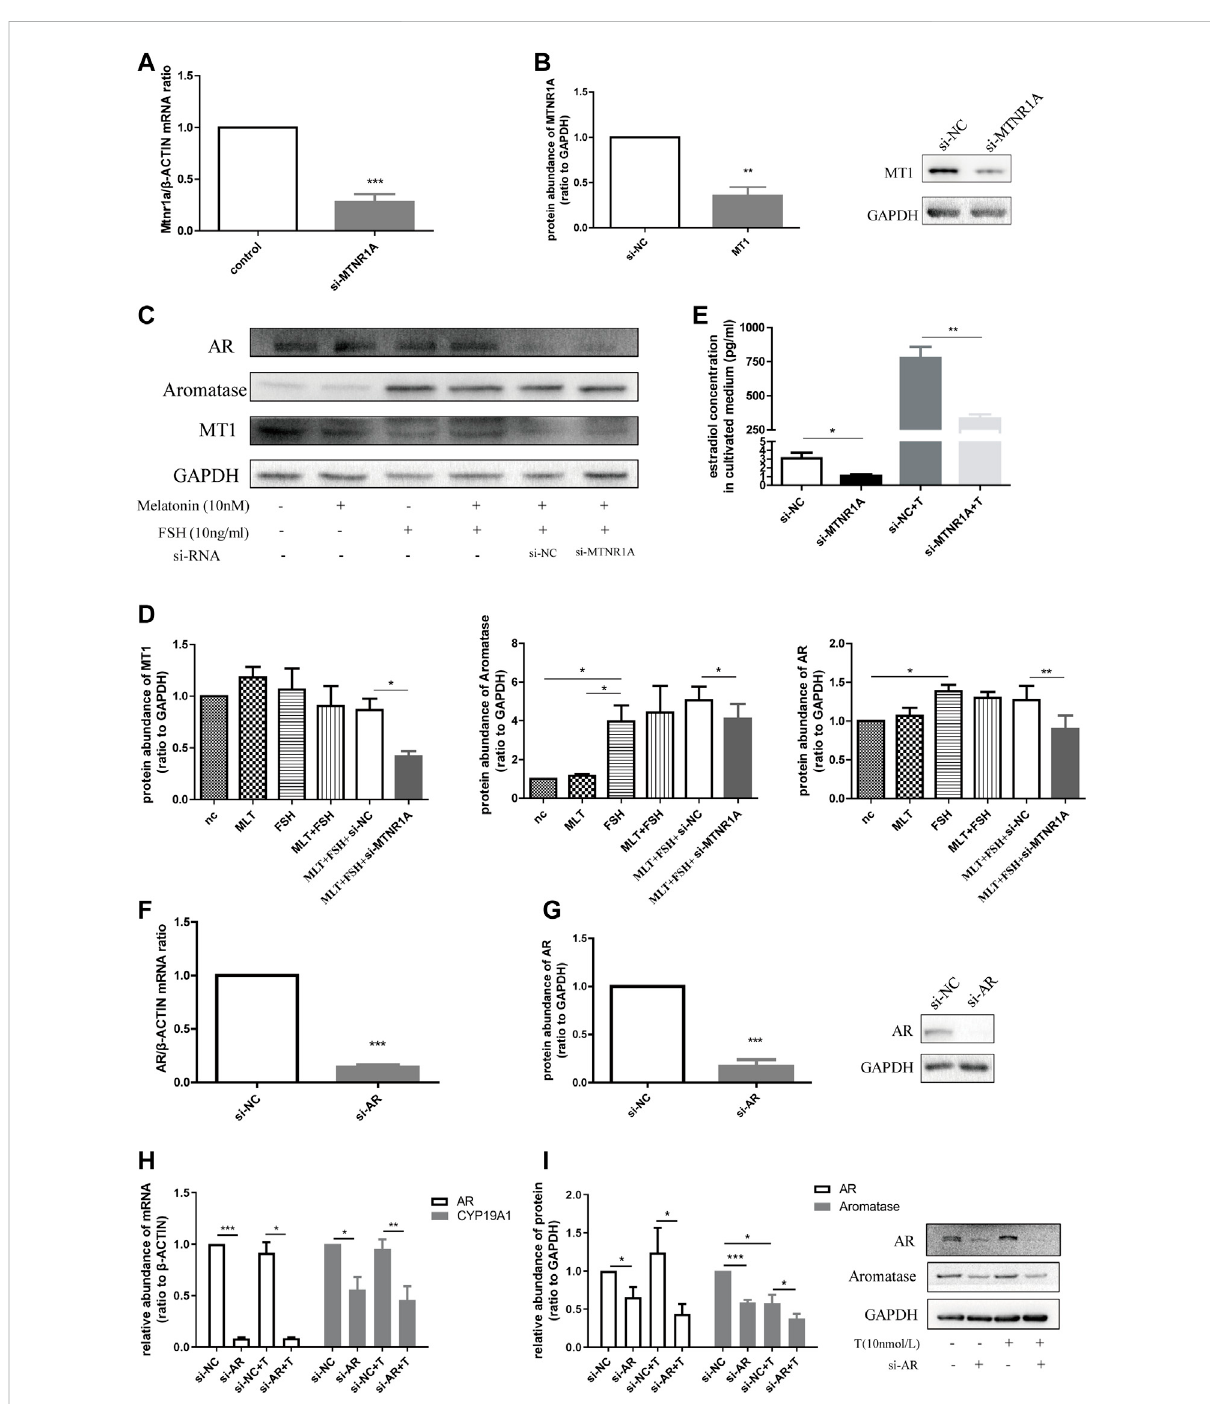
FIGURE 7 Downregulated MTNR1A and AR reduced aromatase expression in the KGN cell line and decreased estradiol concentration in the culture medium. (A,B) Ef fi ciency of MTNR1A- knockdown in mRNA and protein levels, respectively. (C,D) Western blot analysis (C) and quanti fi cation (D) of AR, aromatase, and MT1 after MTNR1A -knockdown and incubation with or without 10 nmol/L melatonin or 10 ng/ml FSH. (E) Estradiol level after MTNR1A -knockdown and incubation with or without 10 nmol/L testosterone. (F,G) Ef fi ciency of AR -knockdown in mRNA and protein levels, respectively. (H,I) mRNA and protein abundance of AR and CYP19A1 after AR -knockdown and incubation with or without 10 nmol/L testosterone, respectively. Values are expressed as means ± SEM. These results are representative of at least three independent experiments. Signi fi cant differences between the two groups are indicated by asterisks (* p < 0.05, ** p < 0.01, and *** p <